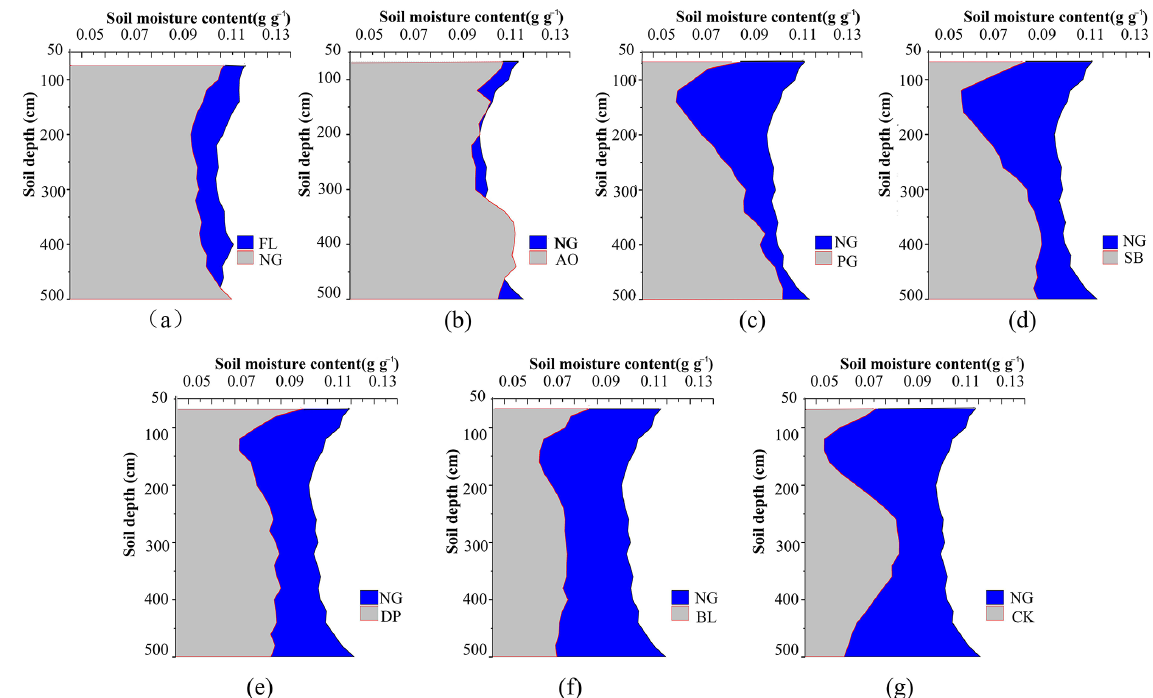
Figure 6. Comparison of deep soil moisture among human-managed vegetation, introduced vegetation and native grasslands: (a) farmland (FL) and native grasses (NG), (b) apple orchard (AO) and native grasses (NG), (c) pasture grasslands (PG) and native grasses (NG), (d) sea buckthorn (SB) and native grasses (NG), (e) David peach (DP) and native grasses (NG), (f) black locust (BL) and native grasses (NG), (g) Caragana korshinskii (CK) and native grasses